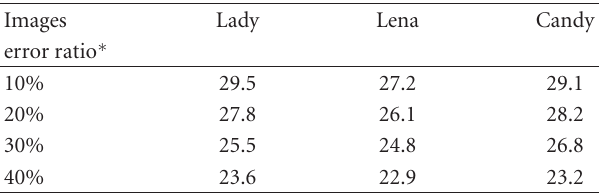
Table 4: PSNR computations for ROI image recovery in various error ratio.